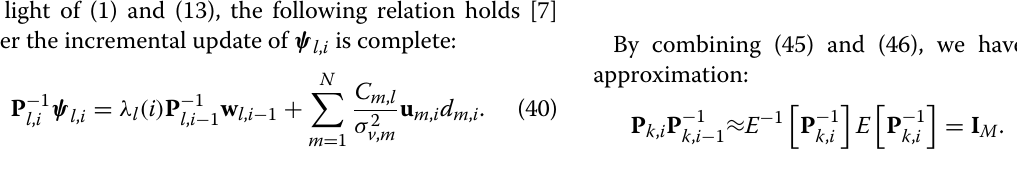
Table 3 Additional computational complexity of the analyzed VFF mechanisms Number of operations for each node at each iteration Multiplications Additions GVFF M 2 + N 2 ( 9 M 2 + 4 M ) + 2 M +